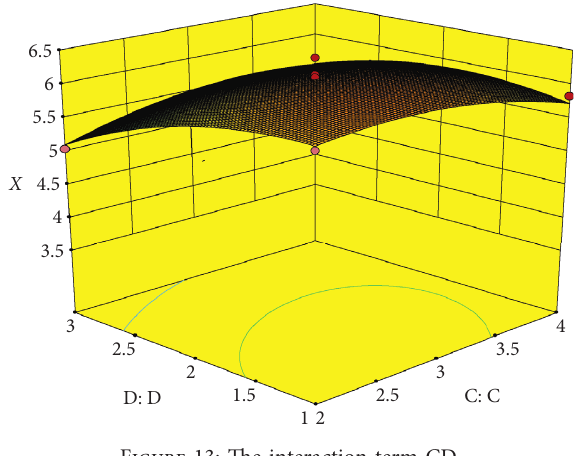
Figure 13: The interaction term CD.